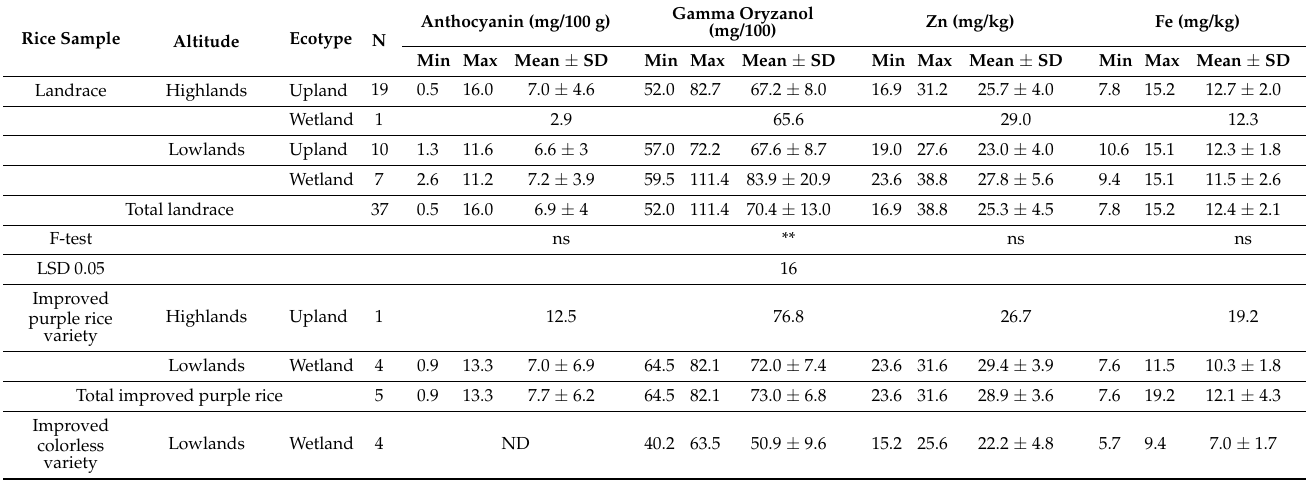
Table 5. Grain quality of purple rice landraces in northern Thailand, by altitude and